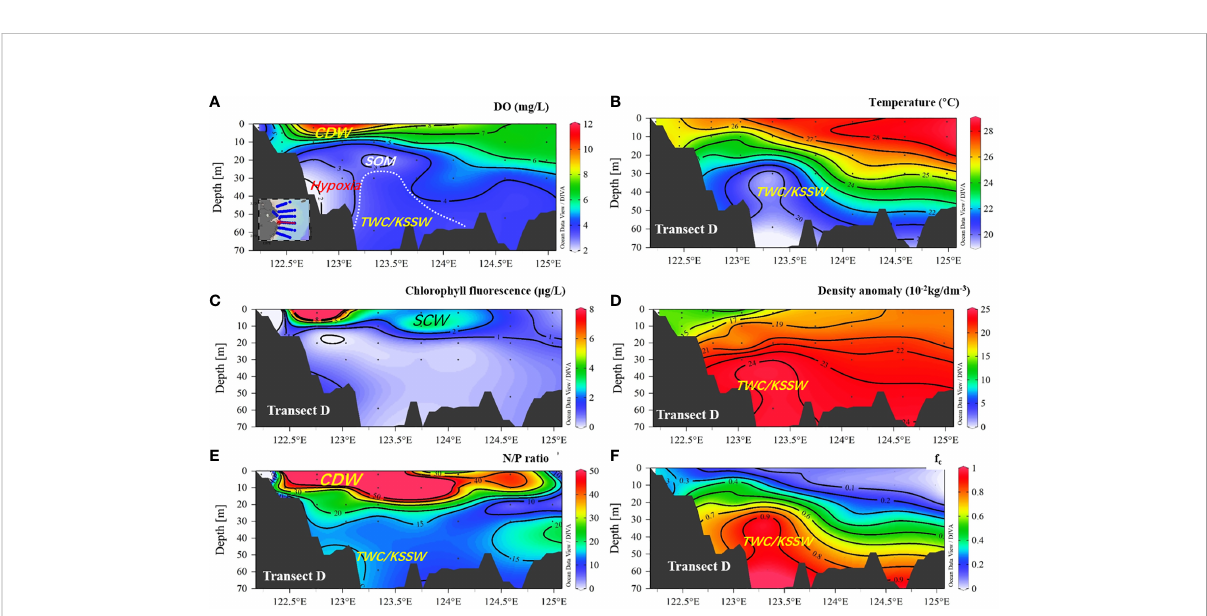
FIGURE 5 Distribution of DO, temperature, chlorophyll fl uorescence, density anomaly, N/P ratio, and fc (fraction of TWC/KSSW) in transect D. (A) DO (mg/ L); (B) temperature; (C) chlorophyll fl uorescence; (D) density anomaly, (E) N/P ratio, and (F) fc (fraction of TWC/KSSW). CDW, Changjiang diluted water; SCM, subsurface chlorophyll a maximum; TWC/KSSW, Taiwan warm current and Kuroshio subsurface